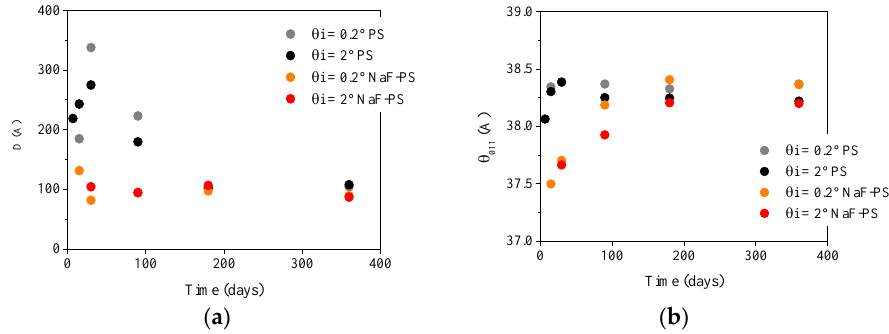
Figure 9. Evolutions of ( a ) D and ( b ) θ 011 of brucite as the function of corrosion duration of MgZr substrates in PS and NaF-PS.